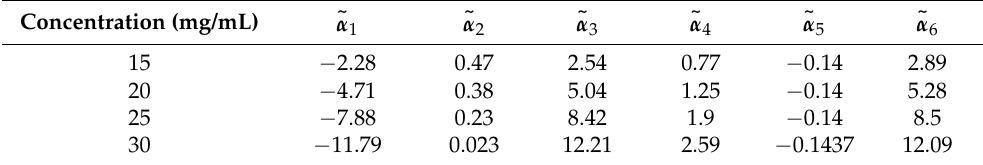
Table 2. Dimensionless Leslie coefficients ( × 100) of nematic GO dispersions at different concentrations. Concentration (mg/mL)